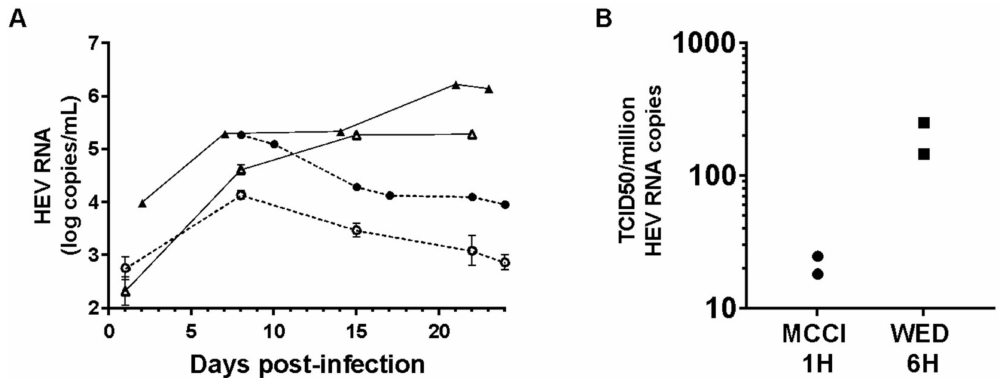
Figure 3. HEV1 culture and infectivity. ( A ) HepG2 / C3A cells were infected with nHEV1 in MCCI at 25 (empty circles) or 50 (filled circles) HEV RNA copies / cell for one hour (dashed line), or in DSD at 15 (empty triangles) or 50 (filled triangles) HEV RNA copies / cell for 6 h (solid line). The graph shows the HEV RNA in the culture supernatant as a function of time (error bars: standard deviations). ( B ) TCID50 / 10 6 HEV RNA copies of nHEV1 ( n = 2) after inoculation of HepG2 / C3A cells with virus suspension in MCCI (circles) for 1-h on or with virus in WED (squares) for 6 h, each followed by cell culture in the inoculum